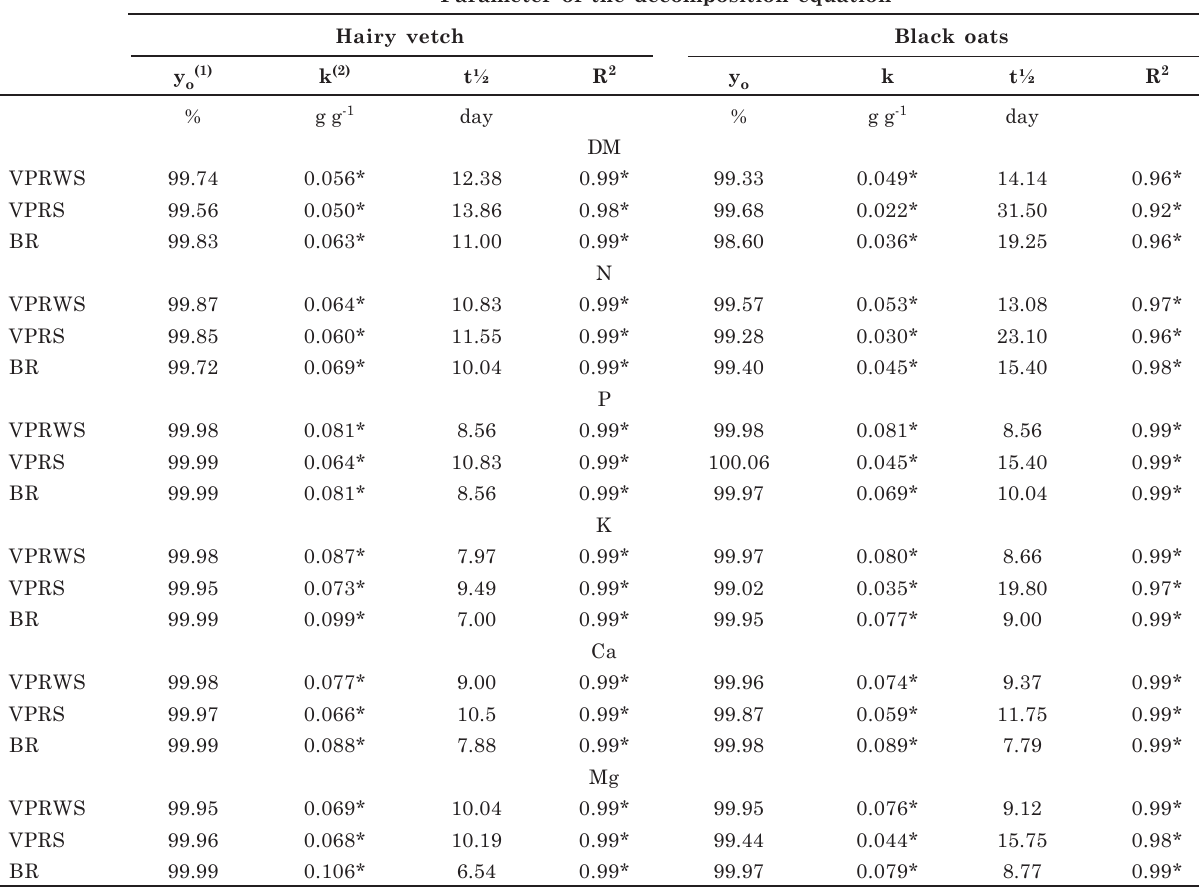
Table 3. Parameters of the models fitted (y = y o e -kt ) to the values of residual dry matter (DM), N, P, K, Ca, and Mg; the half-life time (t½) of each compartment, and R 2 values for the hairy vetch and black oat residues deposited in the vine plant row without plastic shelter (VPRWS), in the vine plant row with plastic shelter (VPRS), and in the between-row area